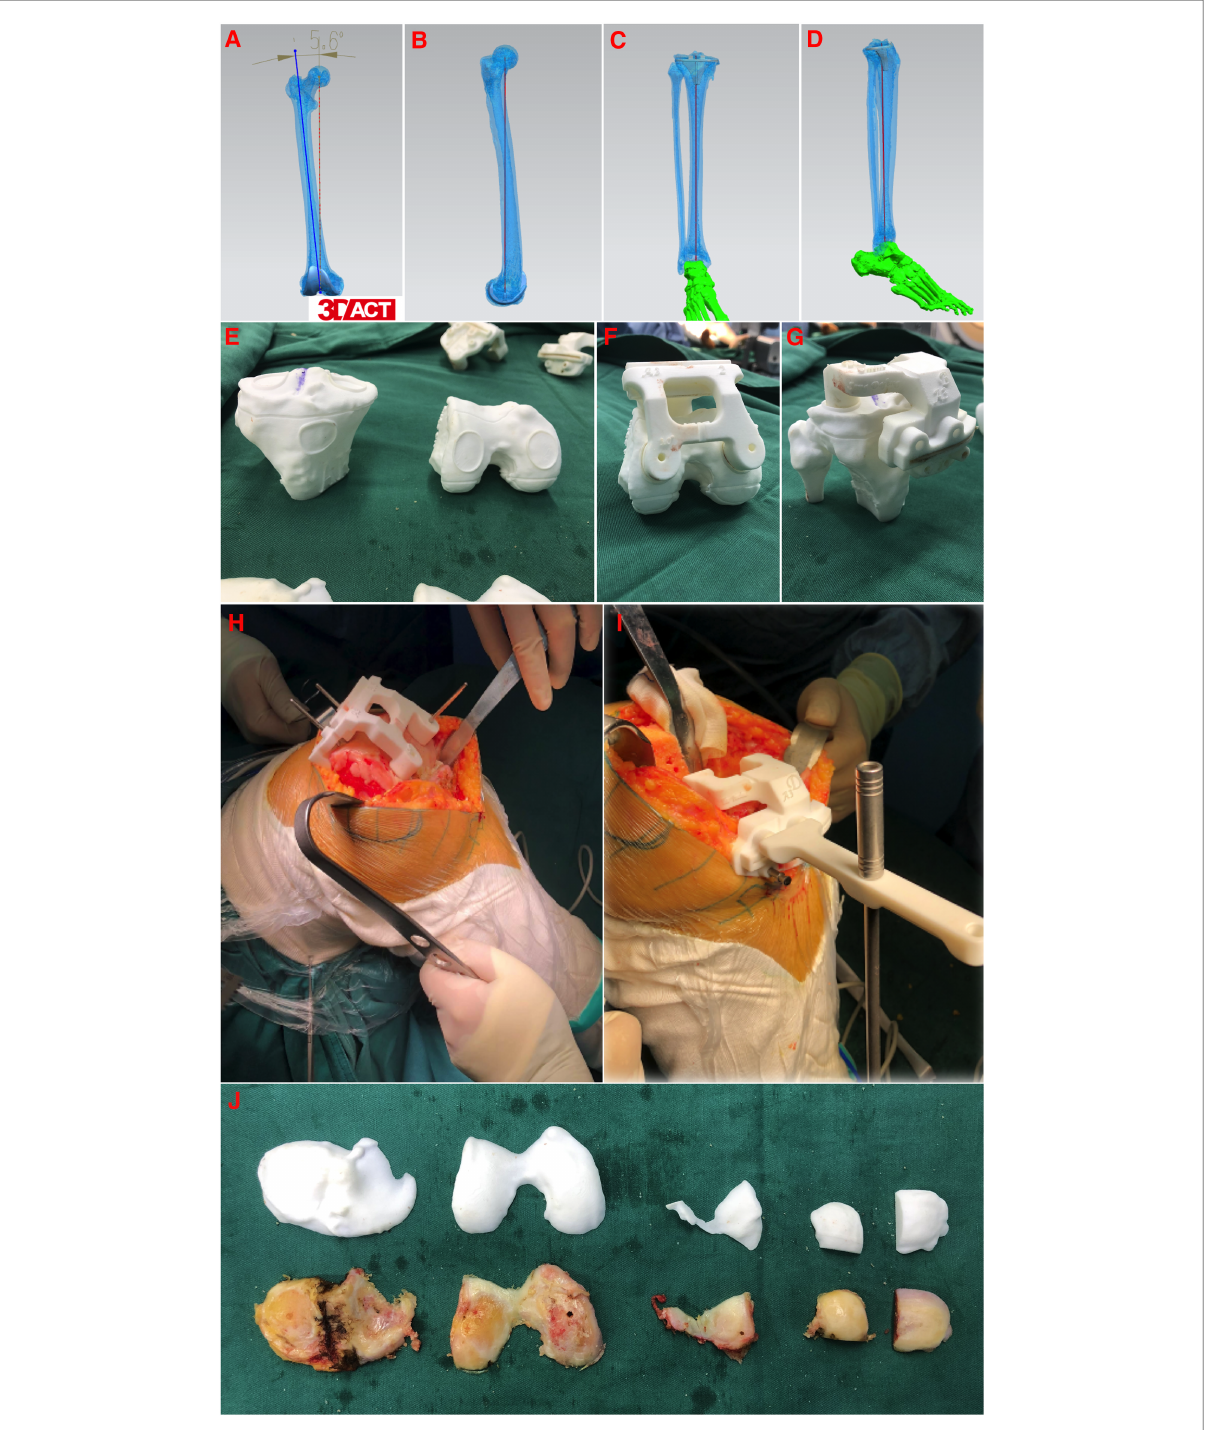
FIGURE 2 Design and intraoperative application of 3D printed patient-speci fi c instrumentations. ( A – D ) CT-based preoperative planning of femoral and tibial prosthetic implant for anatomic reconstruction. ( E ) Reconstructed models of the patient ’ s distal femur and proximal tibia, including markers for the location of the intraoperative osteotomy. ( F,G ) Con fi rming the good fi t of 3D printed patient-speci fi c instrumentations. ( H,I ) Intraoperative positioning and application of 3D printed patient-speci fi c instrumentations. ( J ) Real-time comparison of preoperative designed osteotomy volume and actual osteotomy